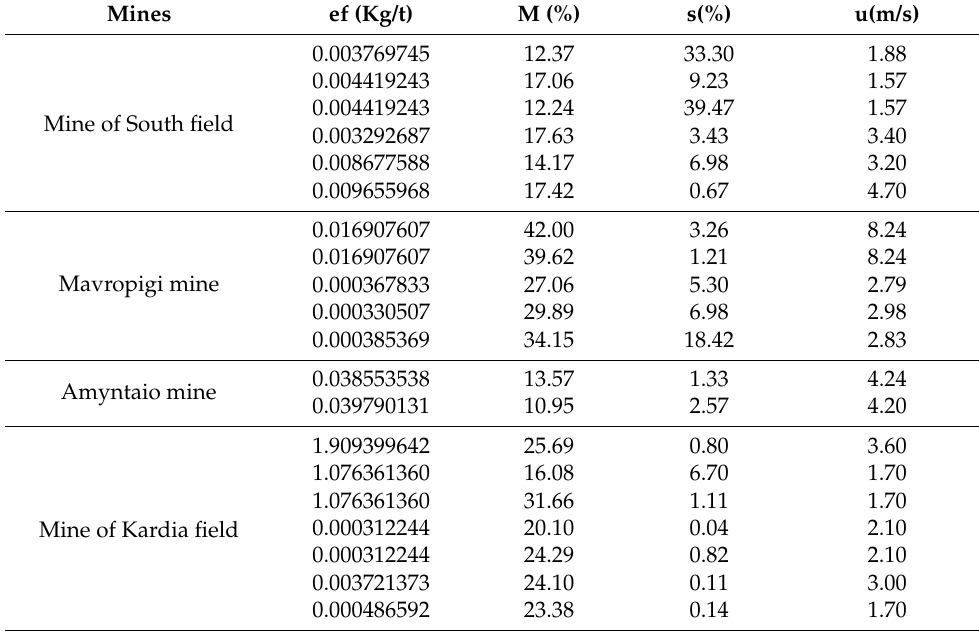
Table 1. Emission factors (ef) and the respective values of moisture content (M, %), silt content (s, %), and wind speed